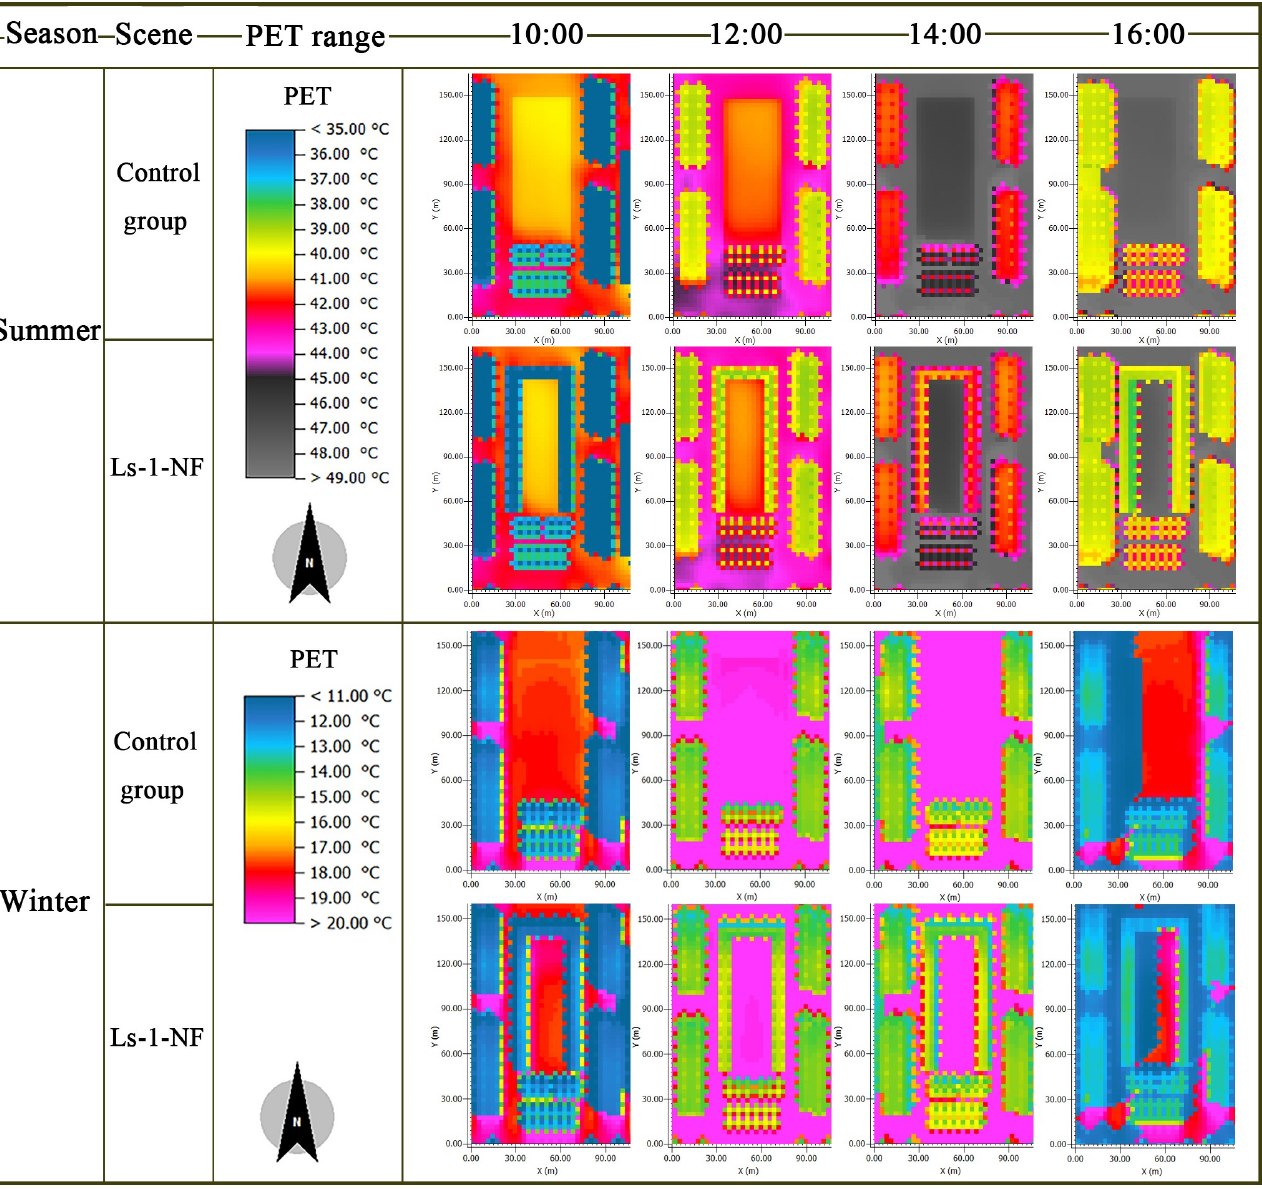
Figure 19. Contour map of PET distribution in different periods of summer and winter.